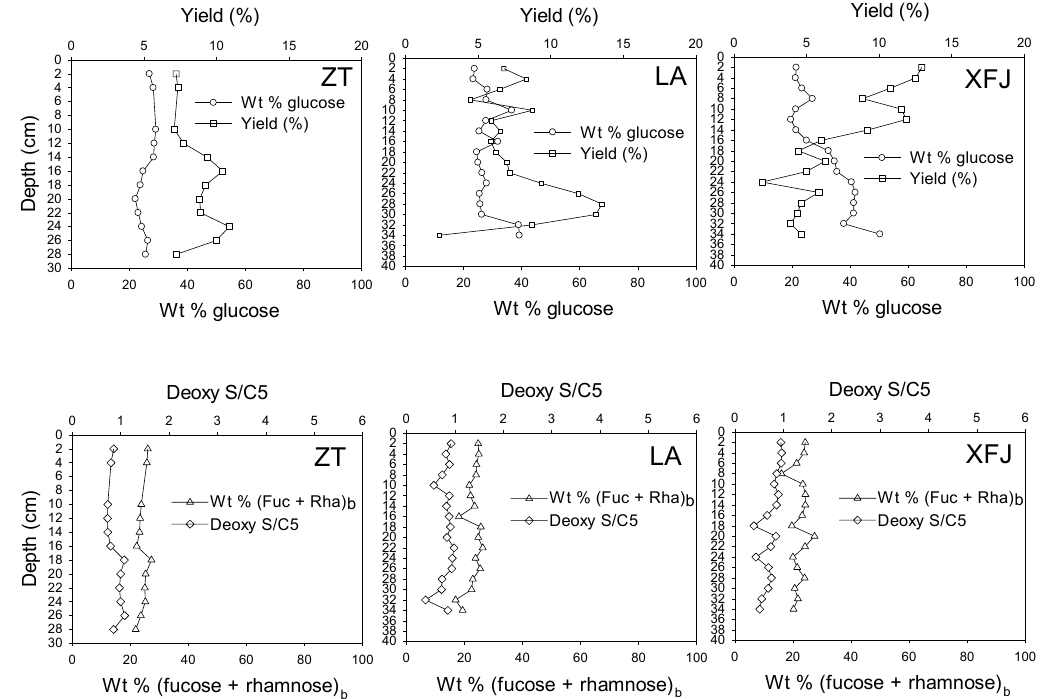
Figure 3. Vertical profiles of yield (%), deoxy S / C5,wt% glucose and wt % (fucose + rhamnose) b in the ZT, LA, and XFJ reservoirs.